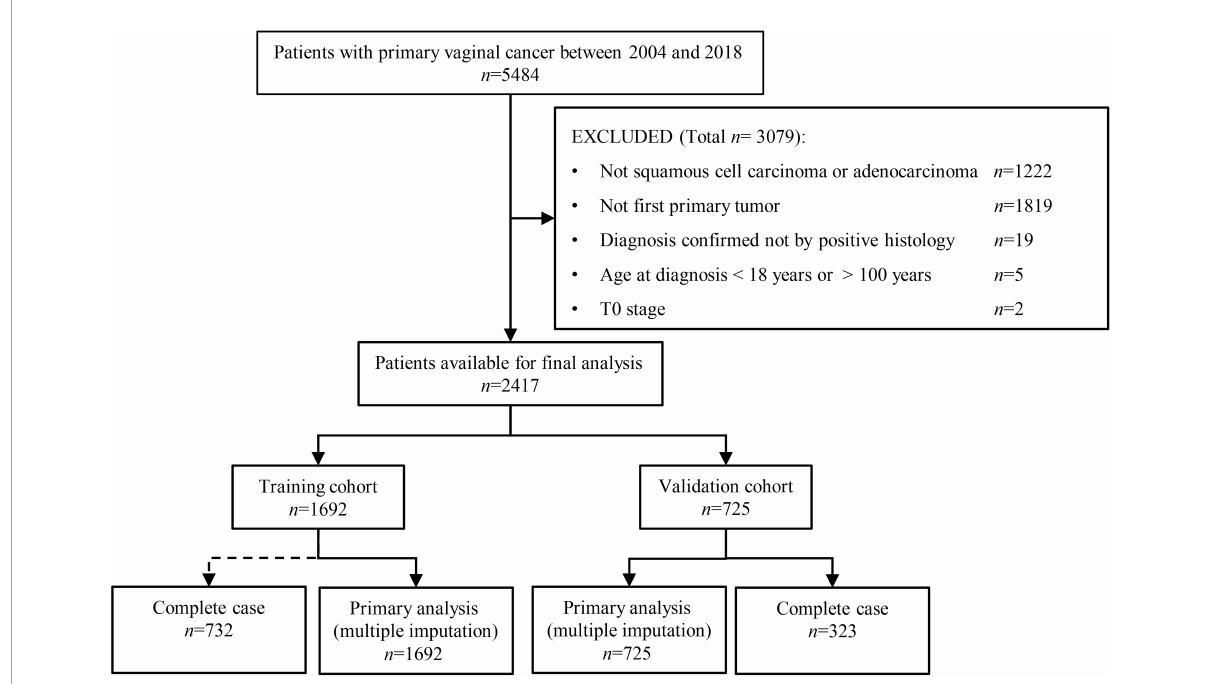
FIGURE1 Patient selection procedure. Of the 5484 vaginal cancer patients diagnosed between 2004 and 2018, 1,692 and 725 patients were finally selected into the training and validation cohorts,